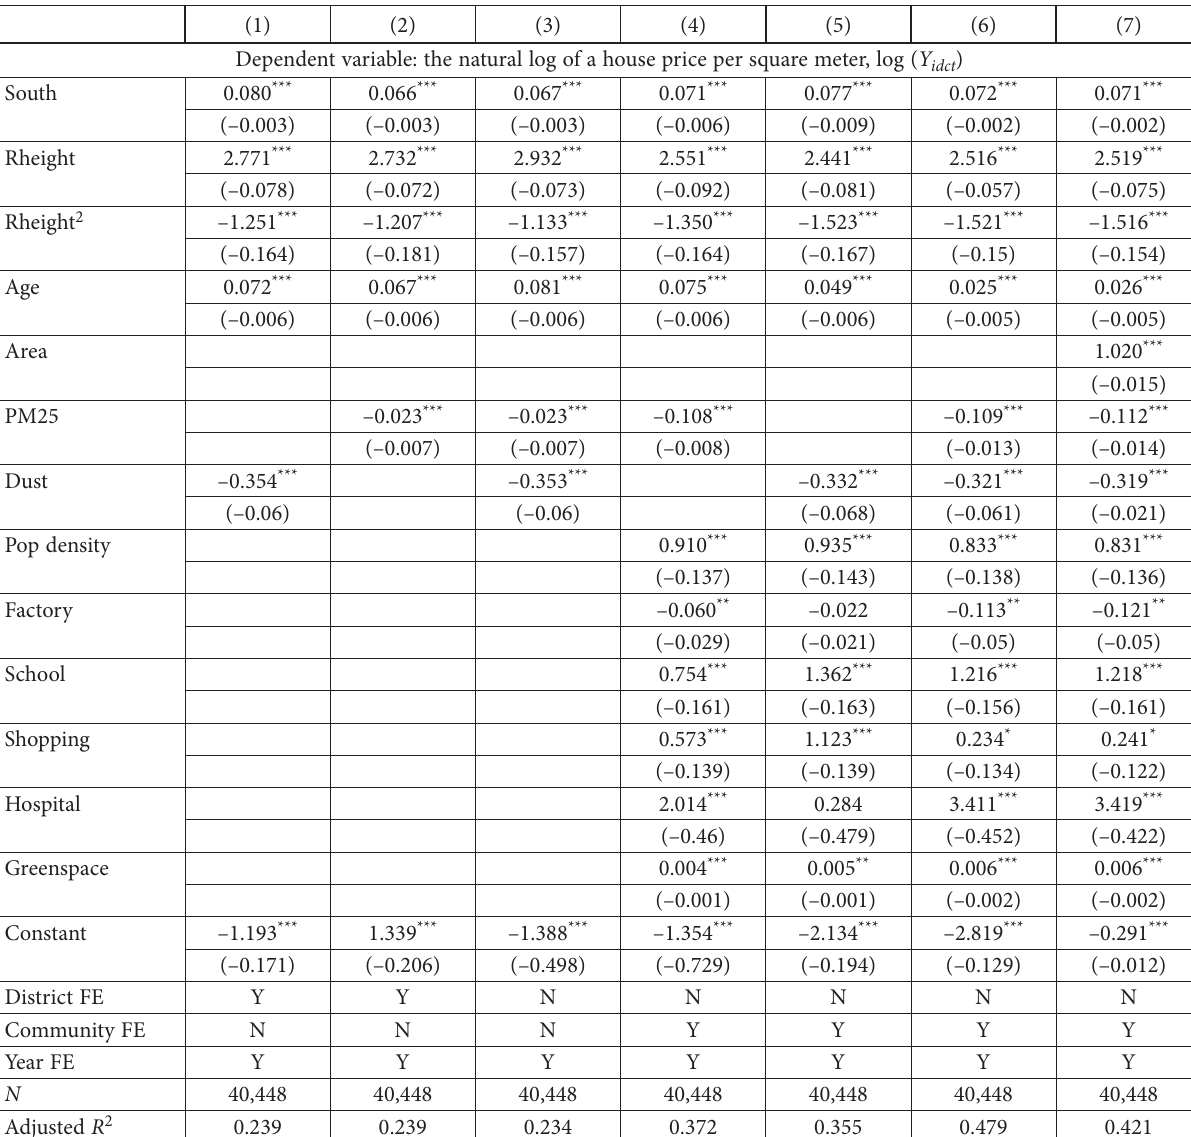
Table 2. The regression results of the baseline model